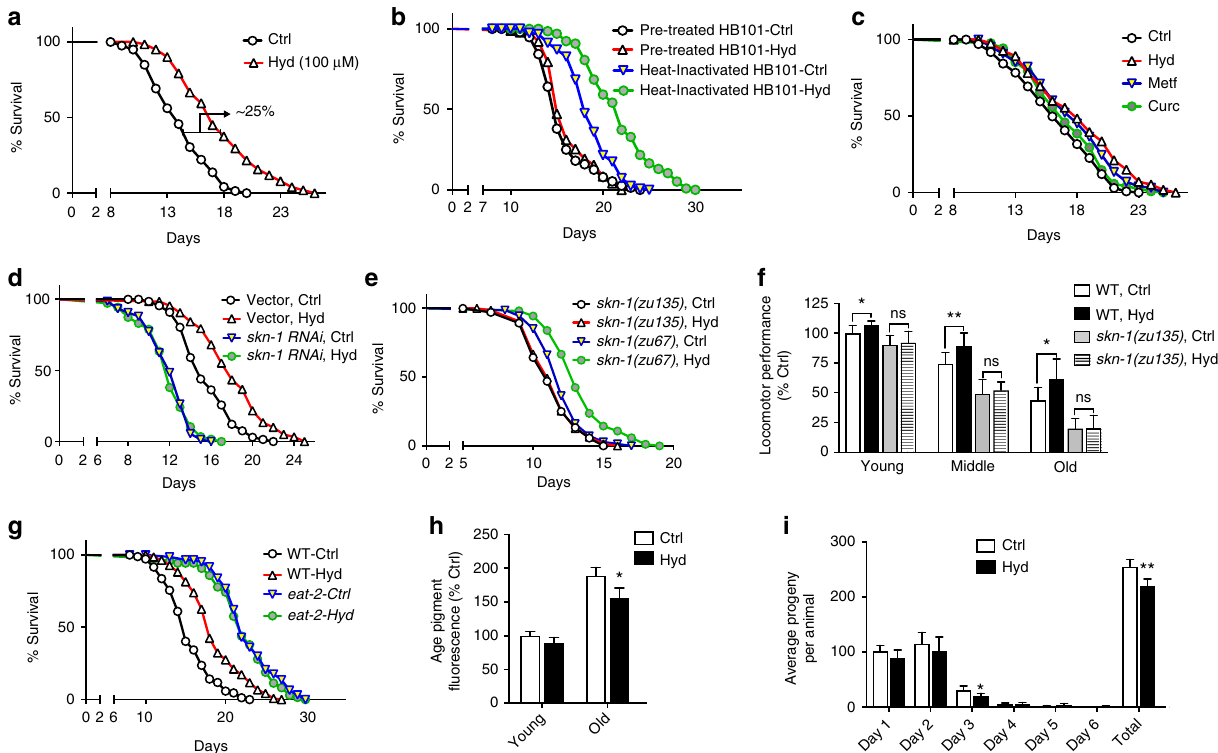
Fig. 5 Hydralazine extension of healthy lifespan in C. elegans is SKN-1 dependent. a Hydralazine treatment (100 µ M) increased C. elegans lifespan by (25%). b Pretreatment of bacteria with 100 µ M of hydralazine did not extend lifespan in wild-type C. elegans but hydralazine treatment (100 µ M) signi fi cantly extended C. elegans lifespan in the presence of heat-inactivated bacteria. c Late-stage (at 10 days of age) administration of hydralazine extended the lifespan of wild-type C. elegans by ~17%, which is comparable to the other prominent anti-aging drugs such as metformin (20 mM). It is worth mentioning that these comparisons are approximate as it is very dif fi cult to determine how much of each drug entered the worm. d Feeding WT worms with skn-1 RNAi completely eliminated the longevity bene fi ts of hydralazine (100 µ M). e Hydralazine treatment (100 µ M) did not extend lifespan in mutant skn-1(zu135) , but expression of functional skn-1 isoform b in skn-1(zu67) partially restored the longevity effects of hydralazine. f Healthspans of wild-type (WT) and skn-1 (zu135) mutant worms were evaluated by measuring locomotor performance in young (5 days for WT, 4 days for mutants), mid-age (10 days for WT, 8 days for mutants) and old (15 days for WT and 12 days for mutants) worms. Hydralazine (100 µ m) prevented an age-related decline in locomotion in wild-type worms but not in the skn-1(zu135) . * p < 0.05 and ** p < 0.01, two-tailed Student's t test, n = 60 three independent trials, mean ± SD. g Hydralazine treatment (100 µ M) did not extend lifespan in eat-2 C. elegans (dietary restriction genetic model) indicating partial overlap between dietary restriction and the hydralazine mechanisms of action. h Quanti fi cation of lipofuscin (age pigment) fl orescence in wild-type C. elegans treated with 100 µ M hydralazine showed deceleration of age-dependent accumulation of lipofuscin. * p < 0.05, two-tailed Student's t test, n = 90 three independent trials, mean ± SD. i Brood size measurement of wild-type C. elegans treated with 100 µ M hydralazine showed reduction in progeny production. * p < 0.05 and ** p < 0.01 two- tailed Student's t test, n = 40 two independent trials, mean ± SD. For all lifespan statistics, see Supplementary Table 372, with mutations of P301L and V337M exposed to recombi- nant tau fi brils that inde fi nitely propagate tau aggregates (aggregate-positive cells, AP). HEK293 cells growing without forming intracellular tau aggregate were used as control (aggre- gate-negative cells, AN) 28 , (3) wild-type C. elegans treated with rotenone, and (4) tauopathy C. elegans model expressing anti- aggregate tau ( byIs194 ) or pro-aggregate tau ( byIs161 ) in the nervous system 29 .